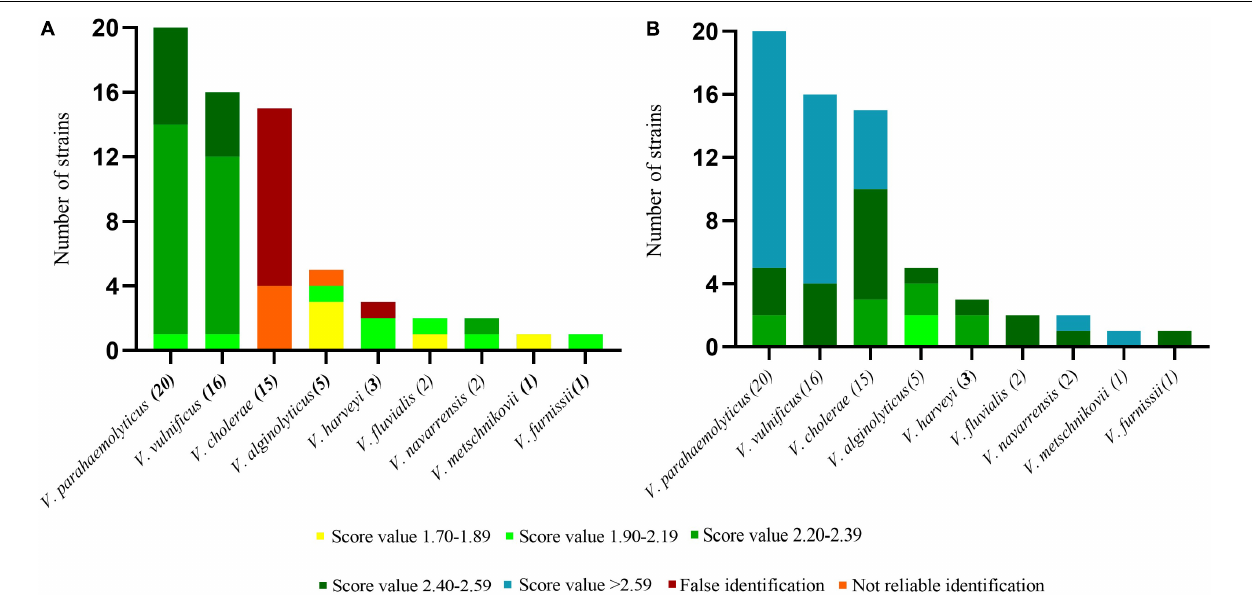
FIGURE 4 | Blind test of identification of Vibrio spp. using MALDI-TOF MS. (A) Results based on the Bruker MBT Library. (B) Results based on the Bruker MBT Library and PVBase combined.